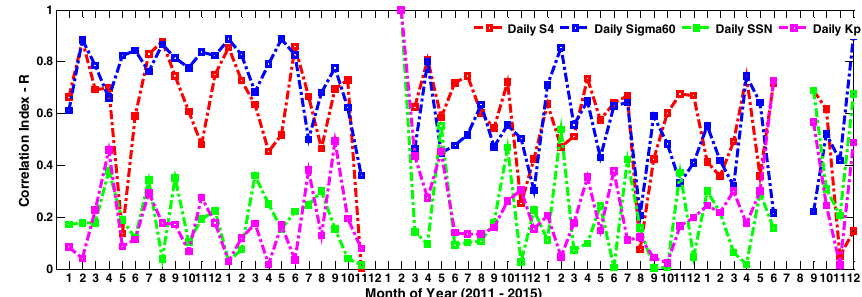
Figure 5. Correlation coefficients between daytime loss of lock percentage and daytime S4, daytime sigma60, daily SSN and daily Kp.